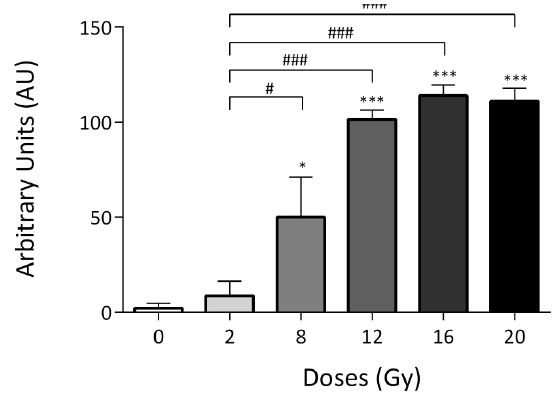
Figure 4. Non Target Effects. ICCM-induced genotoxic damage evaluated in the A549 cell line, plotted like damage index (AU) vs irradiation dose (Gy) and expressed as mean ± SD. One-way ANOVA and post- hoc Tukey’s test, * p < 0,05 and *** p < 0.001 versus untreated control cells; # p < 0,05 and ### p < 0,001 versus cells treated with 2